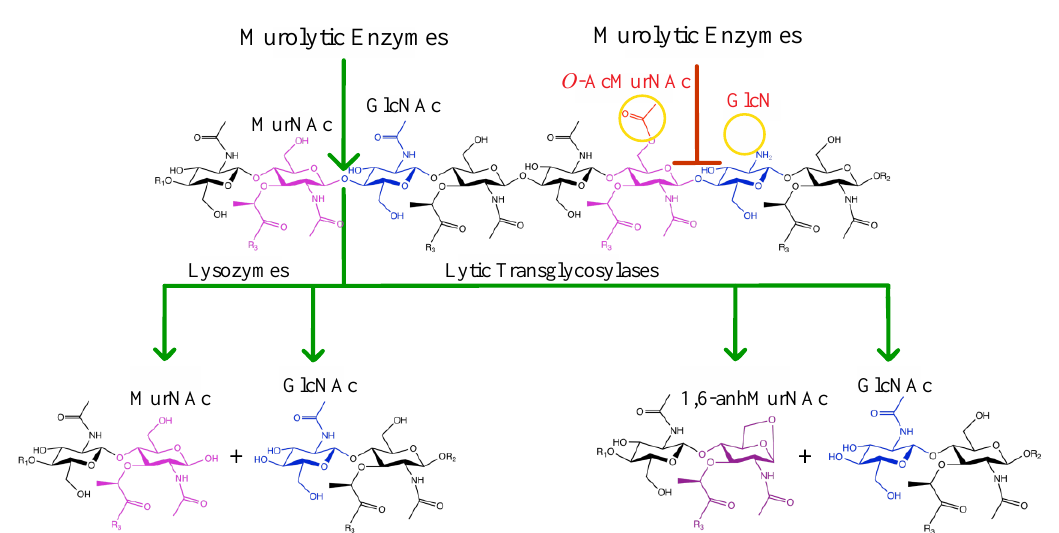
Figure 2. Lytic action and inhibition of murolytic enzymes. Lysozymes as well as endogenous lytic transglycosylases cleave the β (1 → 4) glycosidic linkage between MurNAc and GlcNAc. Lysozyme catalyzes a hydrolytic mechanism releasing two reaction products, one of which terminates in a reducing MurNAc moiety. LTs cleave via a non-hydrolytic mechanism, releasing an equivalent reaction product terminating with a 1,6-anhMurNAc residue. Both classes of enzymes are inhibited by MurNAc O-acetylation while the hydrolytic action of lysozymes is also inhibited by the N-deacetylation of GlcNAc.